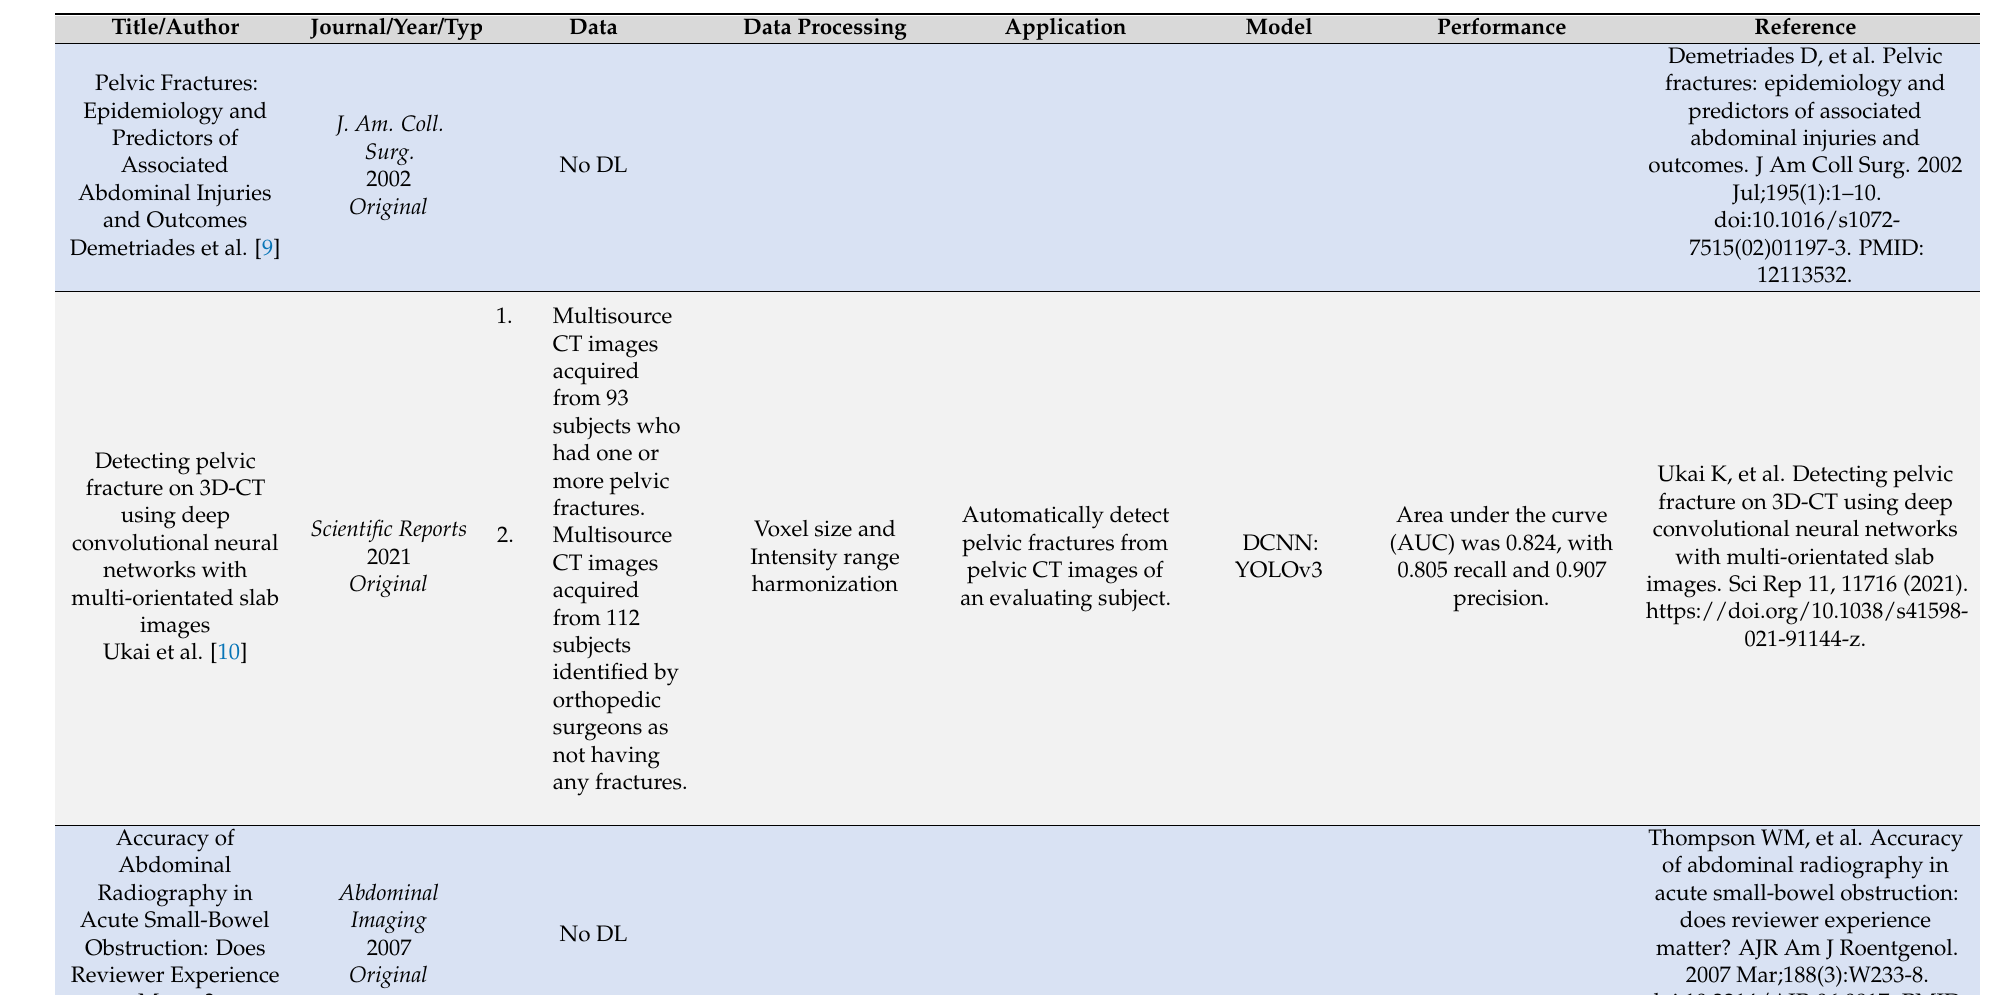
Table 1. Overview of Deep Learning Algorithms Developed For Use in the Emergency and Clinical